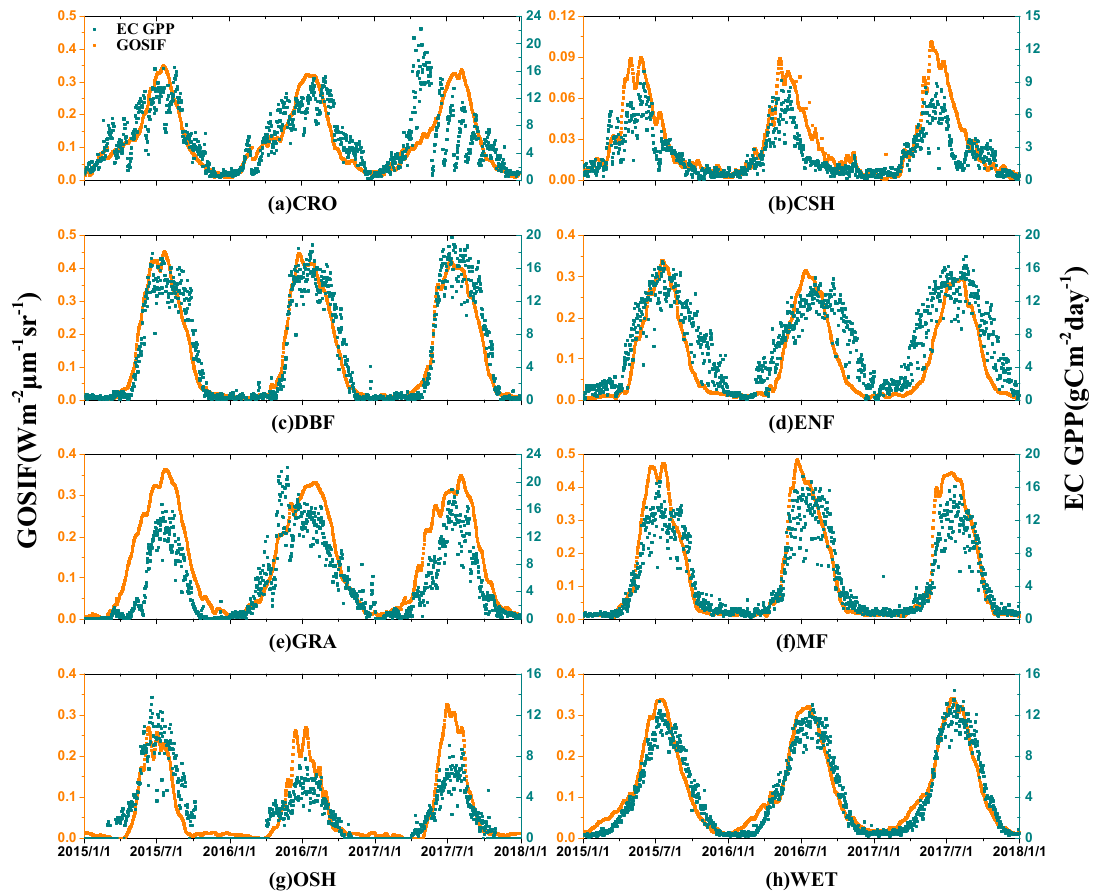
Figure 6. The seasonal trends of tower GPP and GOSIF data from 2015 to 2017 for different vegetation types: (a) CRO, (b) CSH, (c) DBF, (d) ENF, (e) GRA, (f) MF, (g) OSH, and (h) WET. Cyan square indicates flux tower GPP and the orange square indicates GOSIF data.